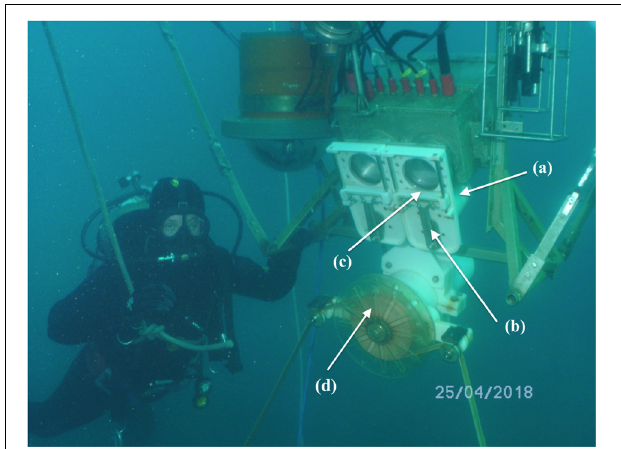
FIGURE 9 | Stereo-optical unit in Kongsfjorden with a mechanical cleaning system (see arrow) for the camera lenses. For each lens, the system comprises (a) a remotely controlled electrical power unit, (b) a connection rod transferring the rotation of the engine to a vertical movement, (c) a wiper construction moving up and down to clean the lens systems, and (d) remote controlled winch system for vertical profiling and positioning the system in the water column. Photos: P. Fischer.